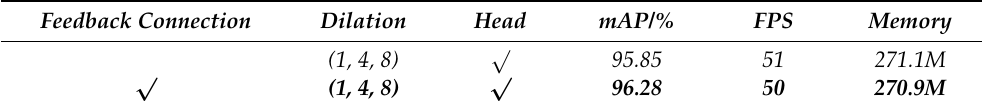
Table 6. Effectiveness of Dilated Encoder Network on